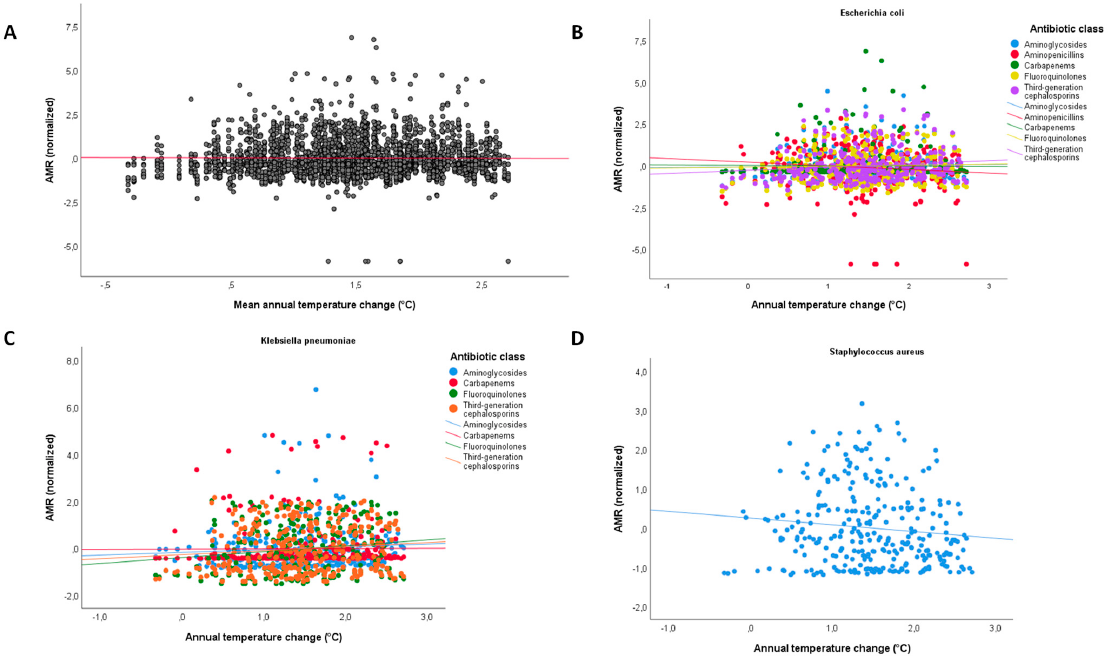
Figure 2. The relationship between annual temperature change and antimicrobial resistance. ( A ) Sca tt er plot of annual temperature change (°C) and antibiotic resistance (normalized) across all countries, years, pathogens, and antibiotic classes. The unadjusted linear trend line is shown in red; ( B ) sca tt er plot of annual temperature change (°C) and antibiotic resistance (normalized) of E. coli across all countries and years. Unadjusted linear trend lines are colored by antibiotic class; ( C ) scat- ter plot of annual temperature change (°C) and antibiotic resistance (normalized) of K. pneumoniae across all countries and years. Unadjusted linear trend lines are colored by antibiotic class; ( D ) scat- ter plot of annual temperature change (°C) and antibiotic resistance (normalized) of S. aureus across all countries and years. The unadjusted linear trend line is shown in blue.